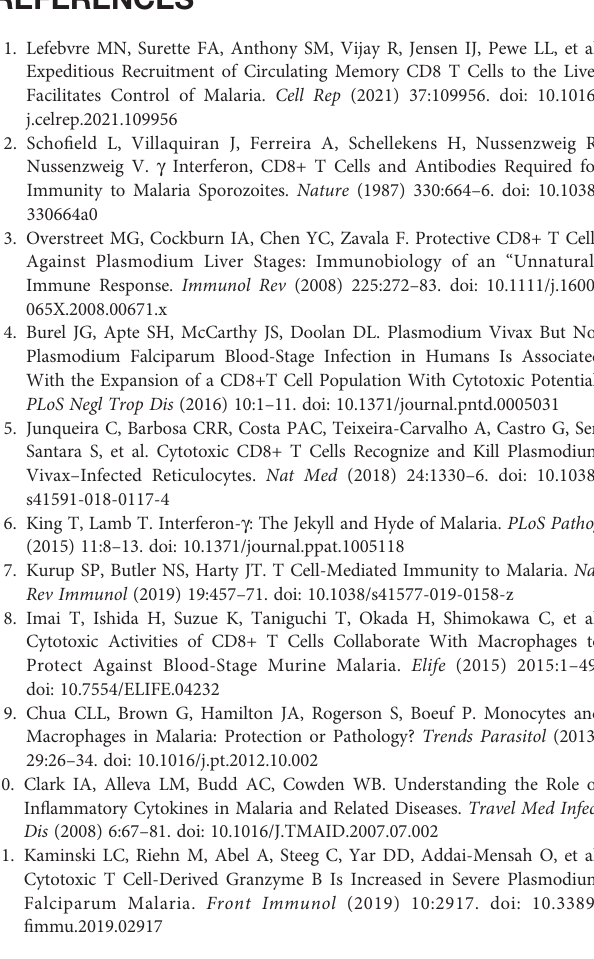
capacity of the respective subset of CD8 + T cells. Supplementary Figure 5 | Expression of co-inhibitory molecules and effector molecules correlate with LAG-3 expression in OT-I mice. MFI of the co-inhibitory molecules PD-1, TIGIT, TIM-3, CTLA-4, CD39 and effector molecules CD107a, Granzyme B, Perforin and IFN- g expressed on CD8 + CD44 + T cells expressing different levels of LAG-3 (CD8 + CD44 + LAG-3 neg , CD8 + CD44 + LAG-3 low , CD8 + CD44 + LAG-3 high ) compared to expression of those markers on CD8 + CD44 - T cells isolated from OT-I mice infected with PbTG. Data were analyzed with Friedmann ’ s test for multiple comparisons. Each dot represents an individual mouse, n=8 from two independent experiments. P values between ≤ 0.05 (*) and ≤ 0.0001 (****) were considered statistically signi fi cant. Supplementary Figure 6 | Correlation of analyzed markers on C57BL/6J ad OT-I mice. Correlation of markers analyzed from the ex vivo staining on CD8 + T cells isolated from infected C57BL/6J and OT-I mice. (A, B) Representative stainings in whichallmarkersareplottedagainsteachother.Theaccompanyingcorrelationmatrix showing (C, D) Pearson´s correlation coef fi cient between the indicated markers was calculatedinGraphPadPrismbasedon25.000CD8 + Tcells.